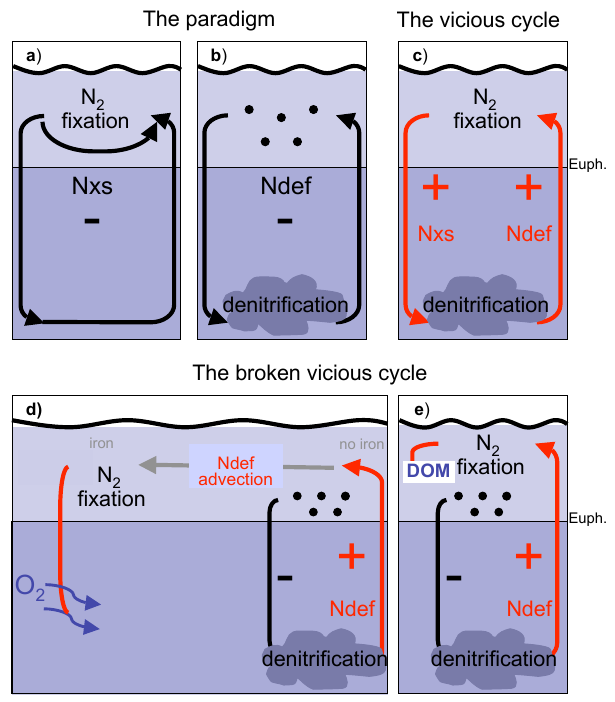
Fig. 1. Feedbacks in the marine nitrogen cycle. Negative feedbacks (black) reduce the initial perturbation. Positive feedbacks (red) am- plify the initial perturbation. Negative feedbacks ensue when two process occur individually: (a) N 2 fixation is self-limited via pro- duction of excess nitrogen (Nxs), and (b) denitrification, is self- limited by the generation of nitrogen deficits (Ndef) that reduce non-fixing phytoplankton export production. If denitrification and N 2 fixation are spatially coupled, then the stoichiometric imbal- ance between the amount of NO − used up in the denitrification 3 process versus the amount of N gained from the remineralization of N 2 fixation-derived organic matter results is a net loss of fixed N that further stimulates N 2 fixation, leading to a vicious cycle con- sisting of positive feedbacks between the two processes (c) . This is because 120 moles of nitrate per mole of phosphorus are used to remineralize Redfield organic matter via denitrification, whereas only 16 moles of nitrogen (per mole phosphorus) are gained dur- ing N 2 fixation. Thus, denitrification of newly fixed organic matter naturally leads to more NO − loss than N gained for any realistic 3 organic matter stoichiometry (see R N equation in main text). To loss break the vicious cycle and allow for the self-limiting individual processes of panels (a) and (b) to dominate, a spatial decoupling of areas of N 2 fixation and denitrification is required. This decoupling can either occur laterally (d) or vertically (e) , mediated by effects of iron limitation, dissolved organic matter and oxygen injections. Light shading represents the euphotic zone and dark shading the low-oxygen waters where denitrification can take place. Black dots represent “non-fixing” phytoplankton. Positive and negative signs and red and black arrows represent positive and negative feedback,